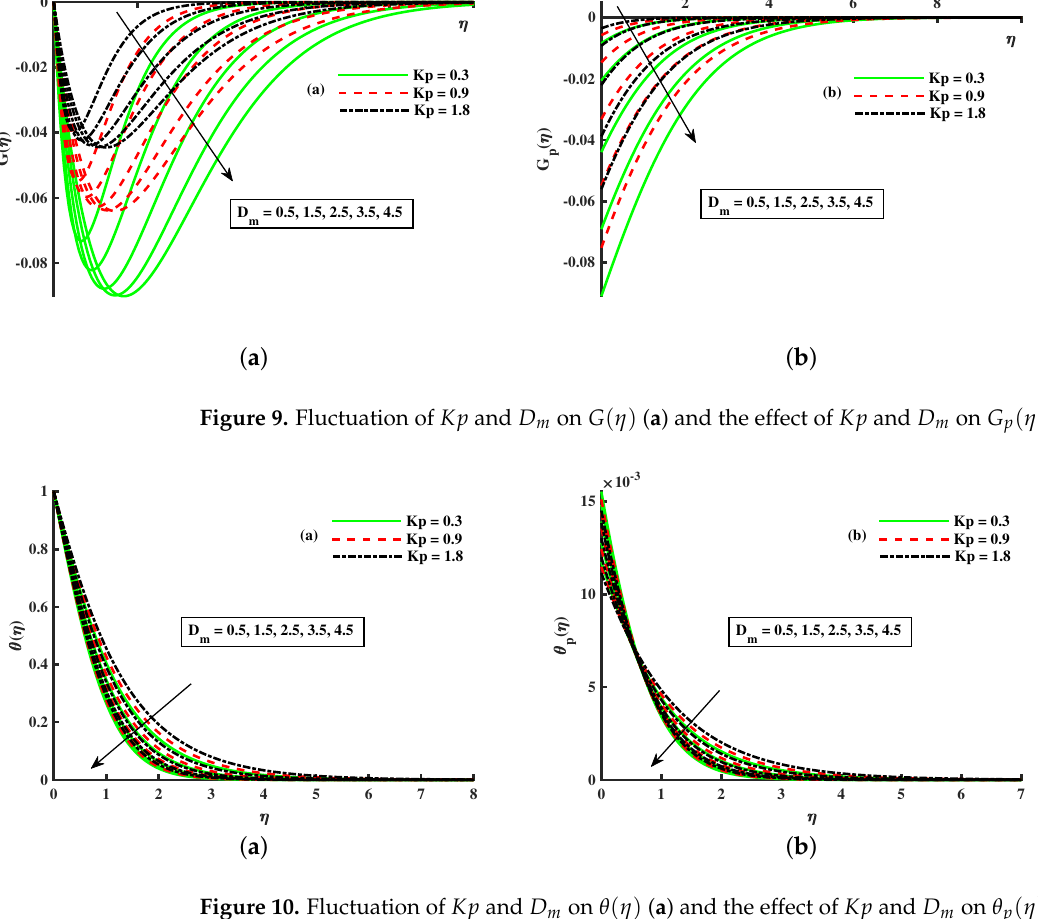
Figure 10. Fluctuation of Kp and D m on θ ( η ) ( a ) and the effect of Kp and D m on θ p ( η ) ( b ).